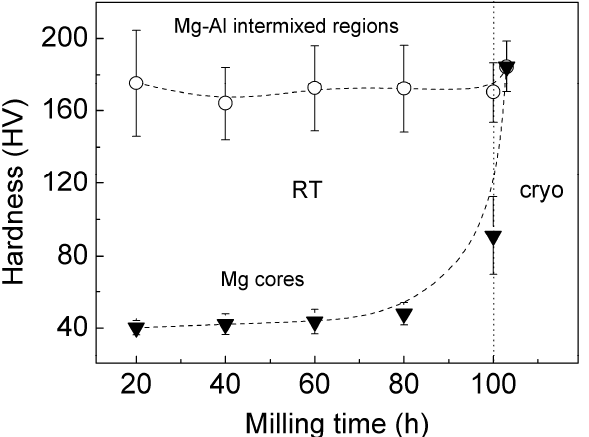
Figure 6. Hardness of the Mg-Al intermixed regions and Mg cores as a function of the milling